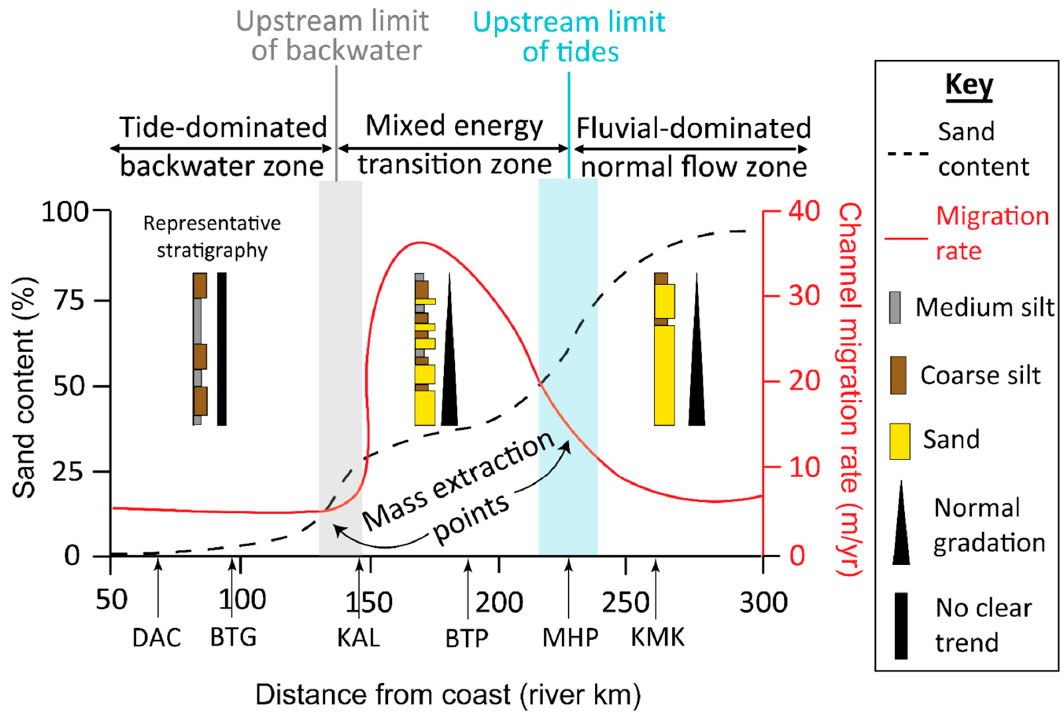
Figure 10. Integrated depositional framework for the tidal to fluvial transition of the Gorai River with representative core profiles for each depositional zone. The upstream extents of the backwater and tidal influence are not singular points in space or time (e.g., Dalrymple and Choi [1]), and as such, are represented as shaded envelopes. The gray shaded zone represents the backwater transition, where parts, but not all, of the channel bed are situated above mean sea level (see Figure 3). The blue shaded zone represents the limit of tidal influence, which varies depending on seasonal conditions, in particular, the magnitude of fluvial discharge.